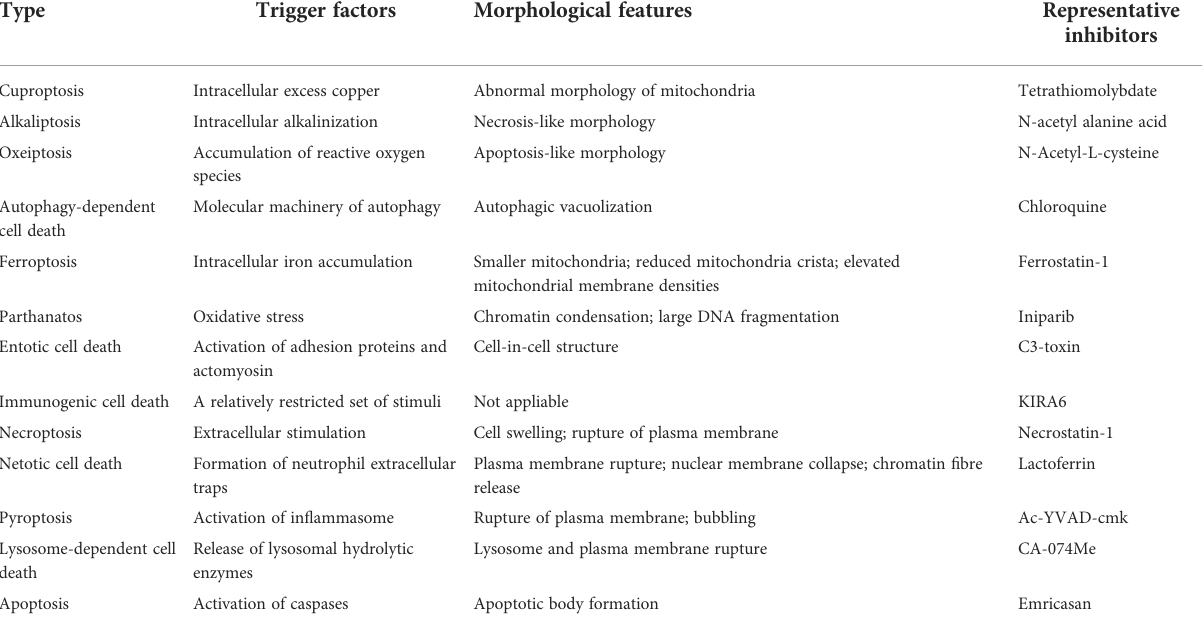
TABLE 5 Hallmarks of major types of regulation of cell